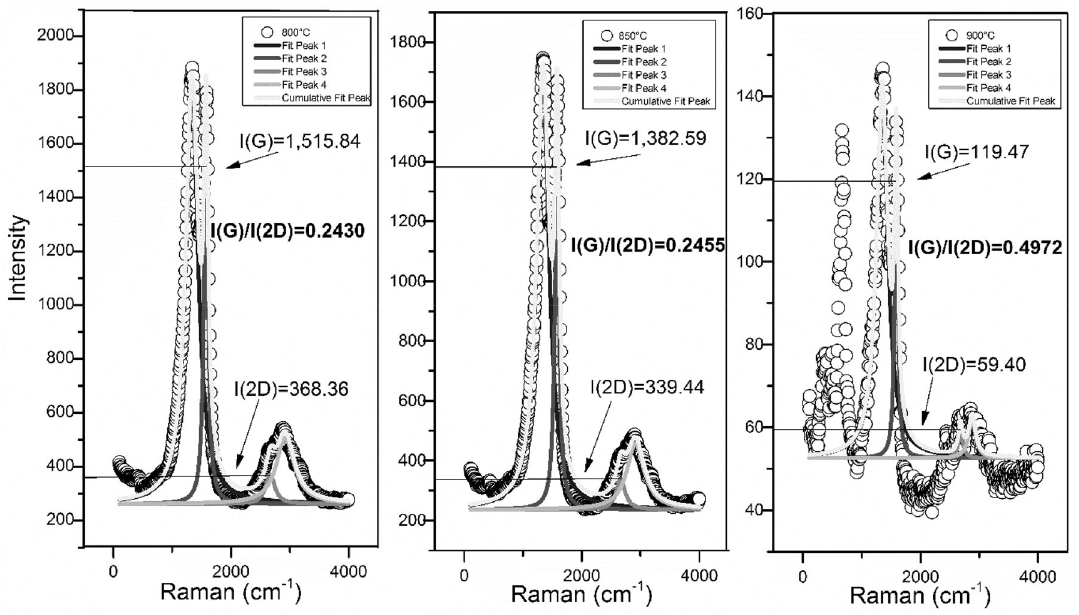
Fig. 8 Comparative of RS results for the sample of solids obtained at temperatures of 800, 850 and 900 (cid:3) C and analysed mathematically for deconvolution of the